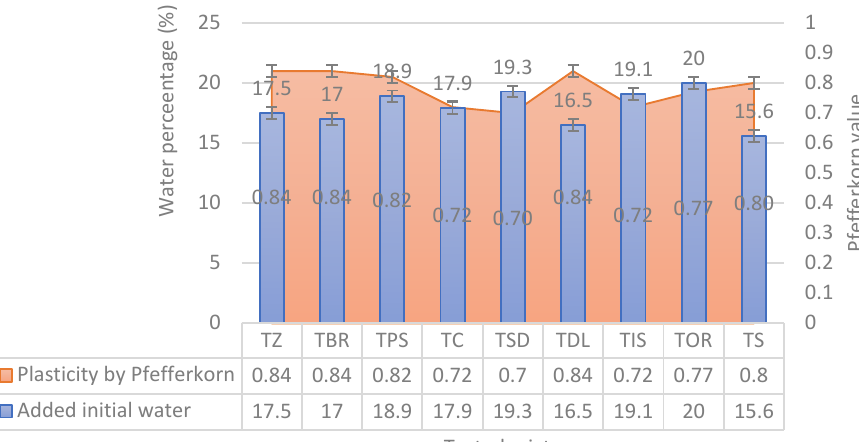
Figure 8. Plasticity by Pfefferkorn and necessary extrusion water for all mixtures.